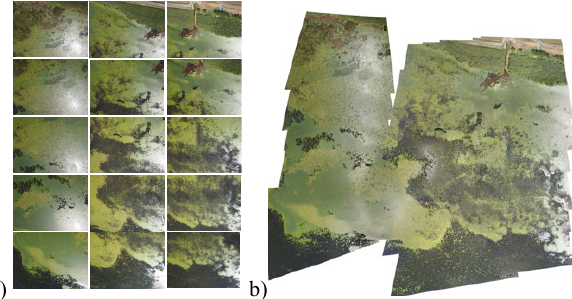
Figure 4. Individual images taken over Lake Inawashiro Fig.2 Example of aerial photographs taken by the UAV. (a) 15 individual images taken over Lake Inawashiro showing floating plants (a) and the produced orthoimage (b). showing floating-leaved plants. (b) Orhophoto mosaicked image made of (a). [1] Microdrones md4-1000, Available: http://www.microdrones.com/.